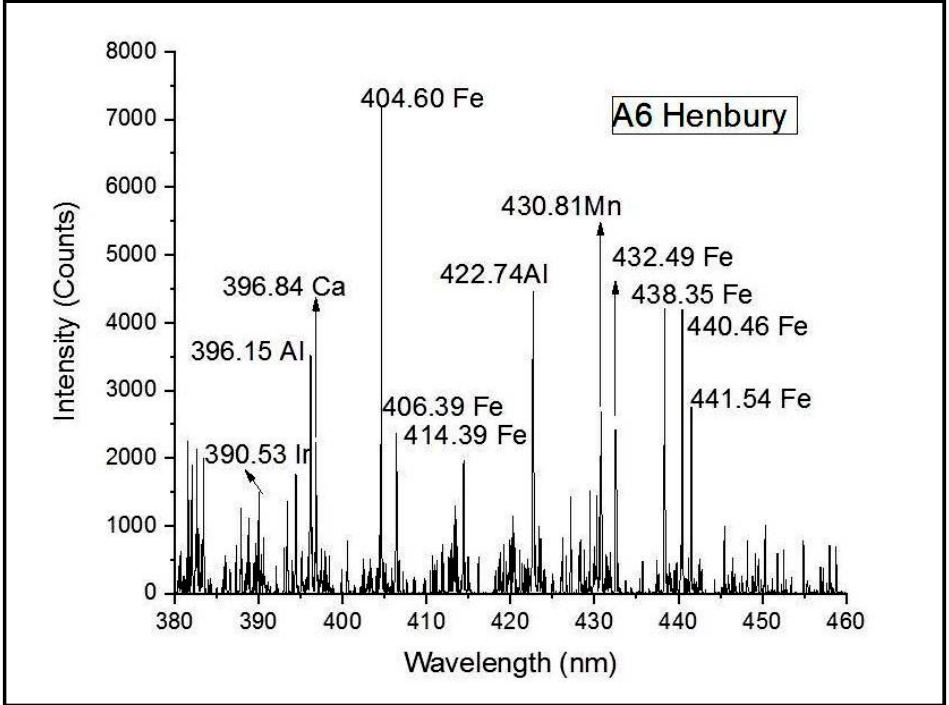
In addition, a strong aluminium line is observed at 422.69nm. In addition to these, lines corresponding to the minor components were observed at 396.84 and 431.89 nm for cal- cium. A closer investigation for more emission from rare Earths from among the less in- tense lines, revealed the presence of samarium and dysprosium corresponding to the Figure 7. LIBS spectrum of sample A6. Reproduced from [28], with the permission of SPIE. emission lines at 382.42 nm and 396.84 nm, respectively.